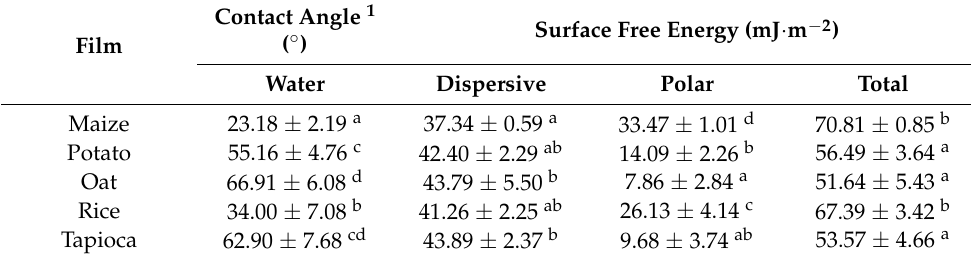
Table 4. The values of water contact angle and surface free energy components.